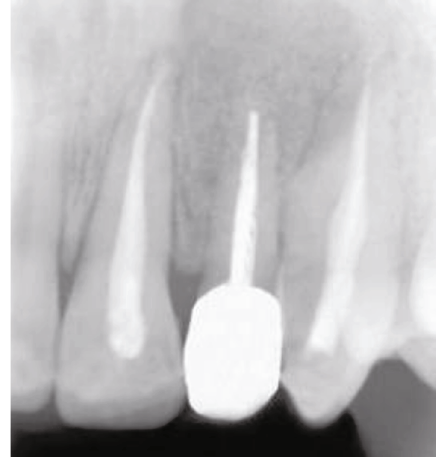
Figure 14: X-ray at 4-year